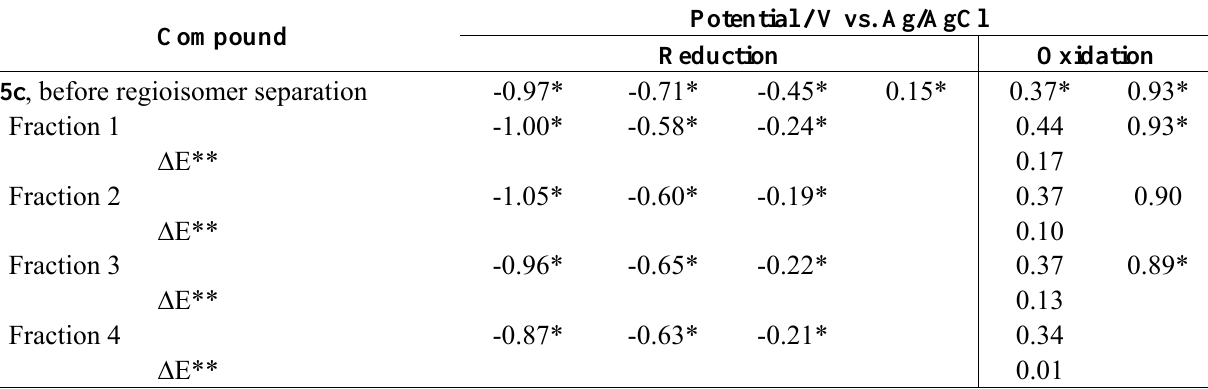
Table 7. Redox potentials of 5c and its